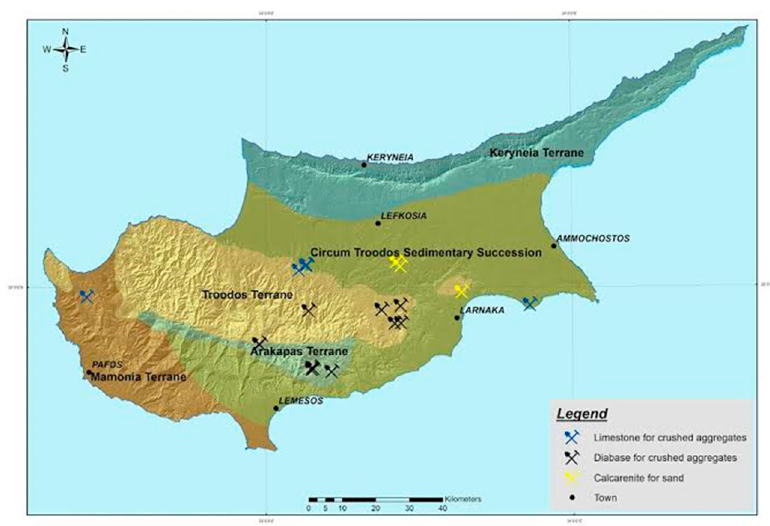
Table 1. List of test samples.